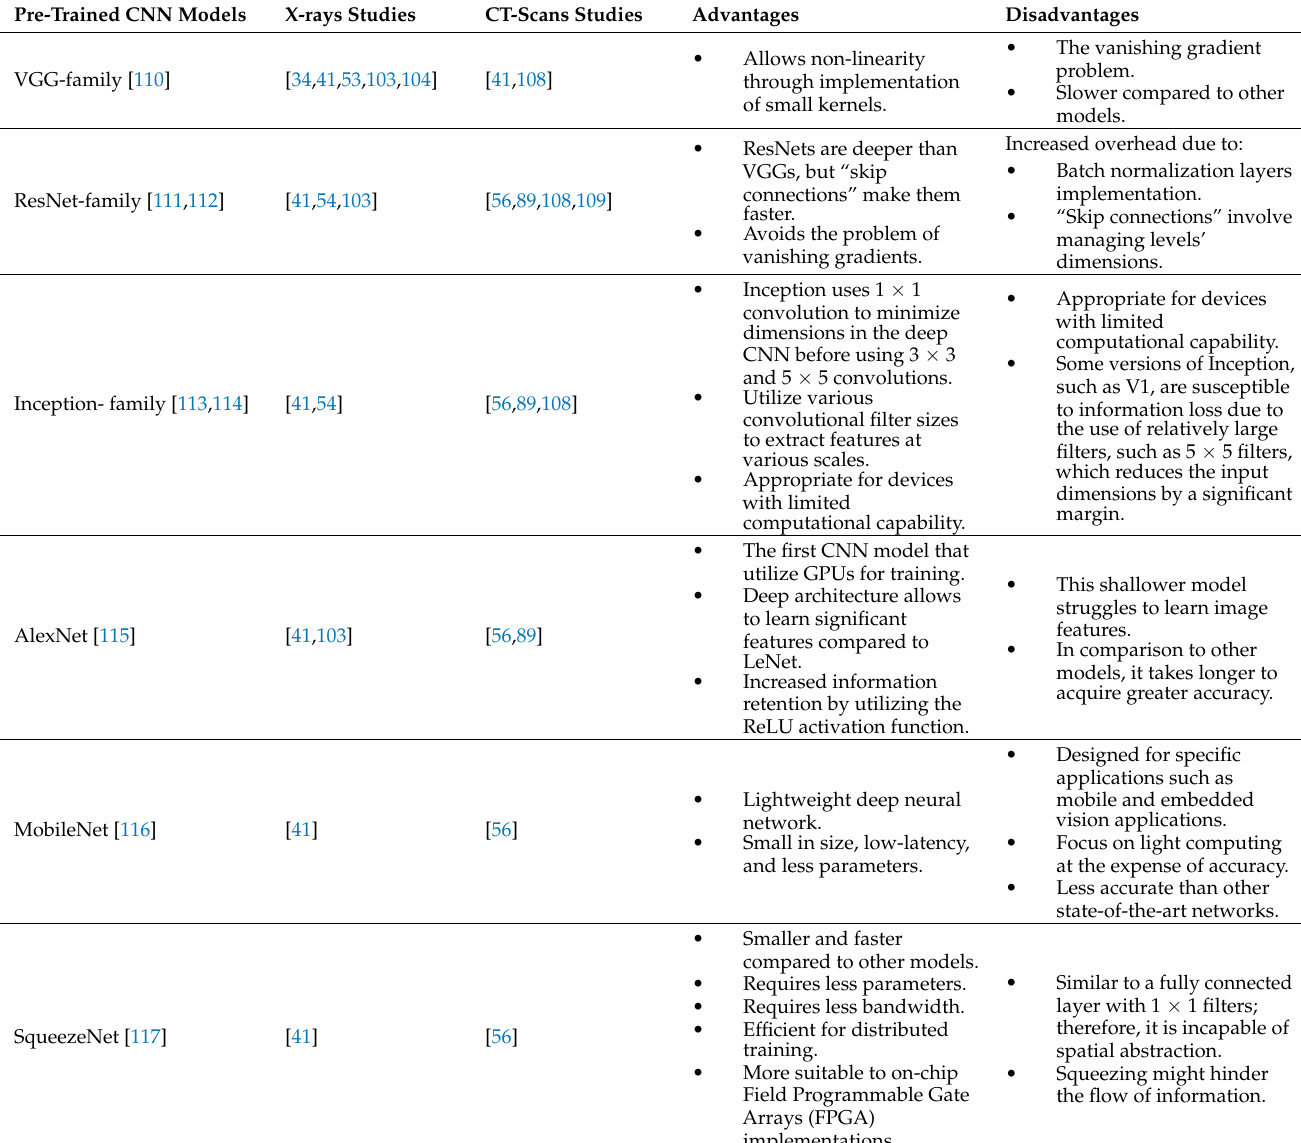
Table 6. Summary of the state-of-the-art of pre-trained